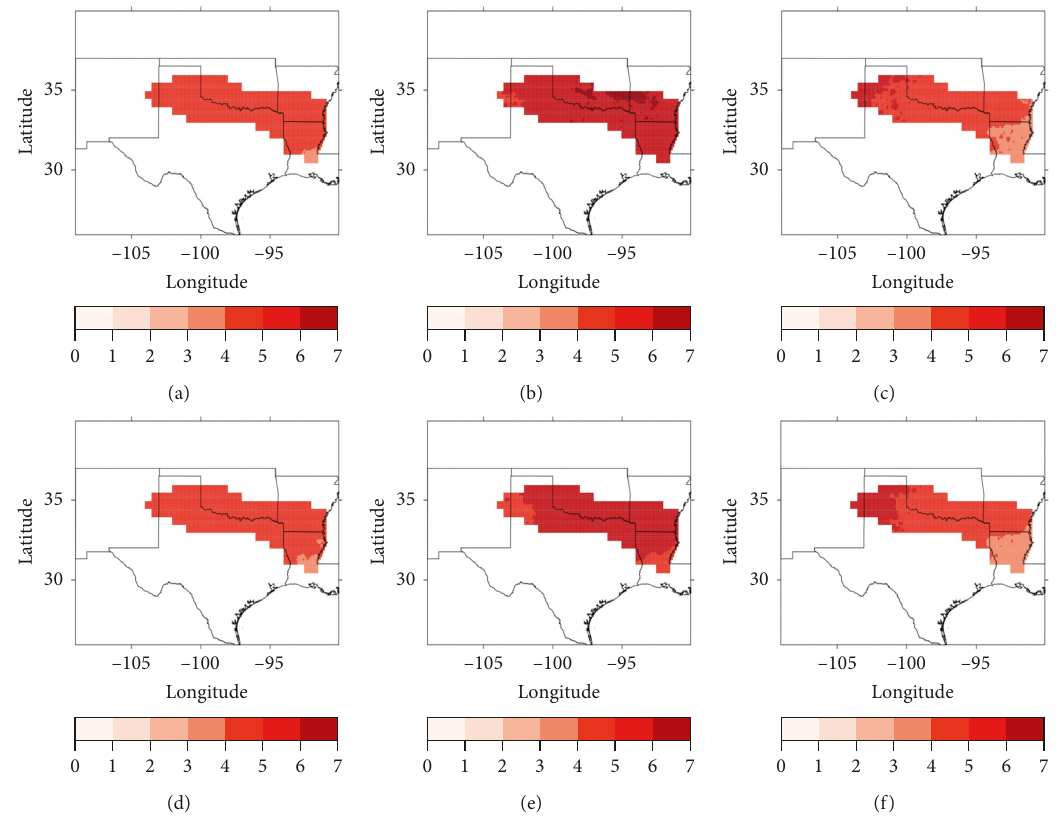
Figure 5: Difference fields for mean daily minimum temperature ( ° C) between historical (1981–2005) and end-of-century (2075–2099) time frames for RCP 8.5. Columns represent the GCMs (CCSM4, MIROC5, and MPI-ESM-LR, from left to right respectively); rows represent downscaling methods, with CDFt on top and EDQM on bottom. Darker shades of red represent higher minimum temperature values. (a) Model: CCSM4, SD: CDFt. (b) Model: MIROC5, SD: CDFt. (c) Model: MPI-ESM-LR, SD: CDFt. (d) Model: CCSM4, SD: EDQM. (e) Model: MIROC5, SD: EDQM. (f) Model: MPI-ESM-LR, SD: EDQM.